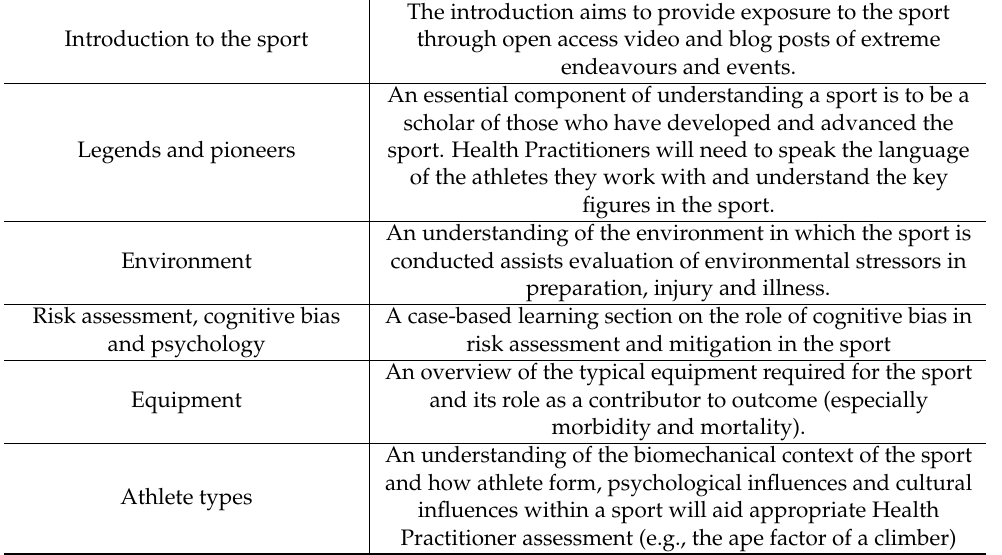
Table 1. Template for individual sports and rationale for inclusion in